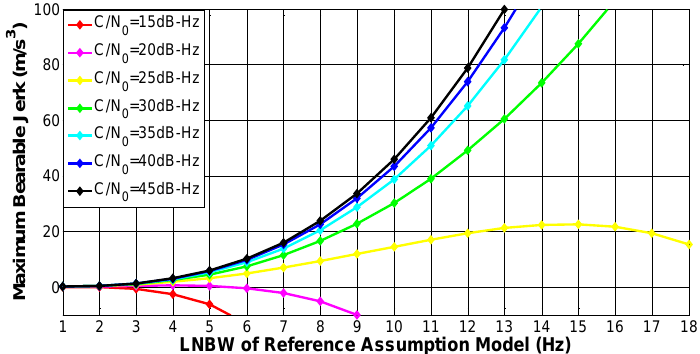
Figure 2. The maximum bearable LOS jerk under different C/N 0 for SSV RRAM.